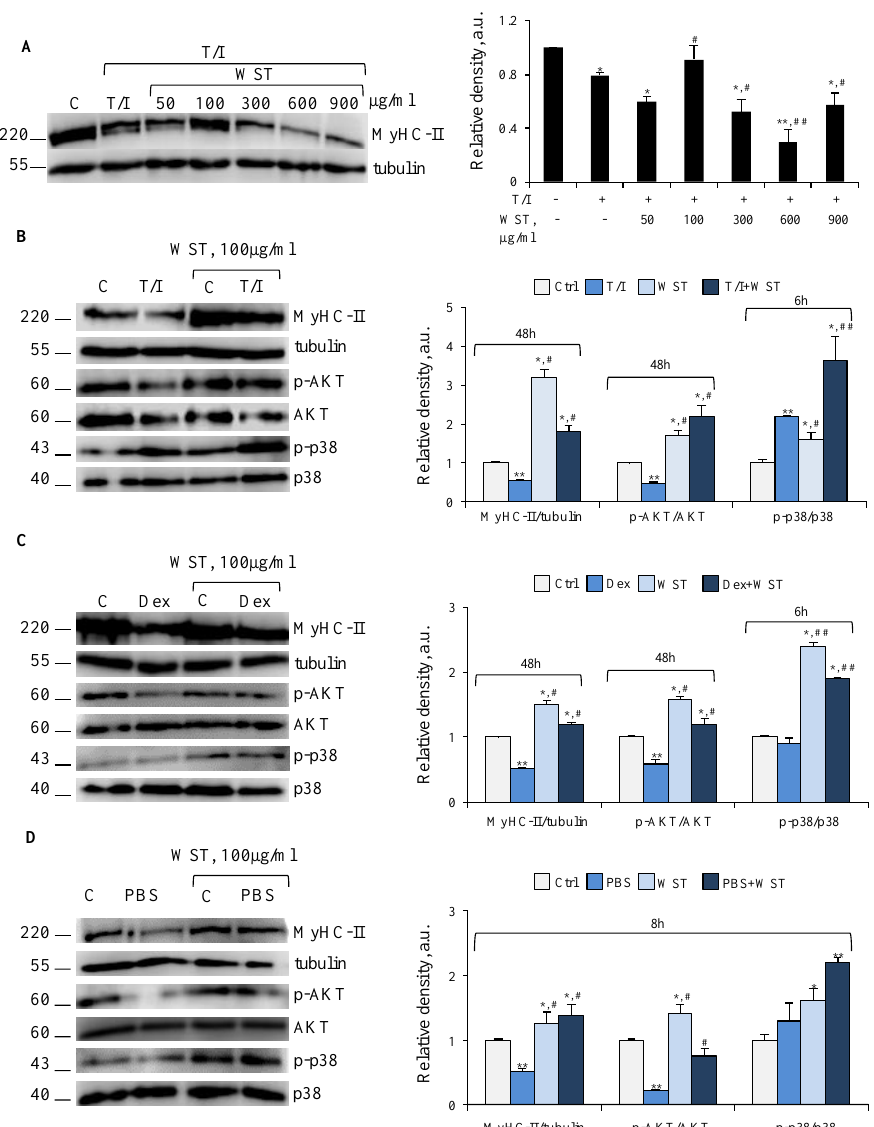
Figure 4. ( A ) C2C12 myotubes were treated with TNFα (tumor necrosis factor α, 20 ng/mL)/IFNγ (interferon γ, 100 U/mL) (T/I) in the absence or presence of different doses of WST for 48 h and myosin heavy chain (MyHC)-II expression were analyzed by WB (western blotting). ( B – D ) WST was tested on myotubes untreated or treated with T/I ( B ) or dexamethasone (Dex, 1 µM) ( C ), or starved with PBS (phosphate buffered saline) ( D ) for indicated time-points. MyHC-II, p-AKT (phospho-protein kinase B), AKT, p-p38 MAPK (phosphor-p38 mitogen-activated protein kinase) and p38 MAPK expression were analyzed by WB. Tubulin was used as a loading control ( A – D ). Reported are representative images and the relative densities with respect to tubulin or total form of phosphorylated protein ( A – D ). Results are means ± SD (standard deviation) ( A – D ). Statistical analysis was conducted using t-test * p < 0.05, ** p < 0.01 significantly different from untreated control; # p < 0.05 and ## p < 0.01 significantly different from T/I ( A , B ), Dex ( C ) or PBS ( D ).